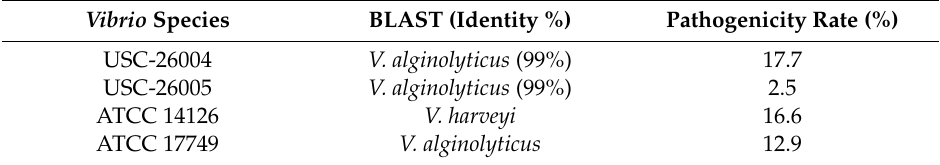
Figure 1. Phylogenetic tree of the pathogenic Vibrio sp. (USC-26004) in relation to its closest relatives. Table 1. Recorded mortality (%) of oyster ( Saccostrea glomerata ) larvae in challenge tests when exposed to di ff erent Vibrio isolates.